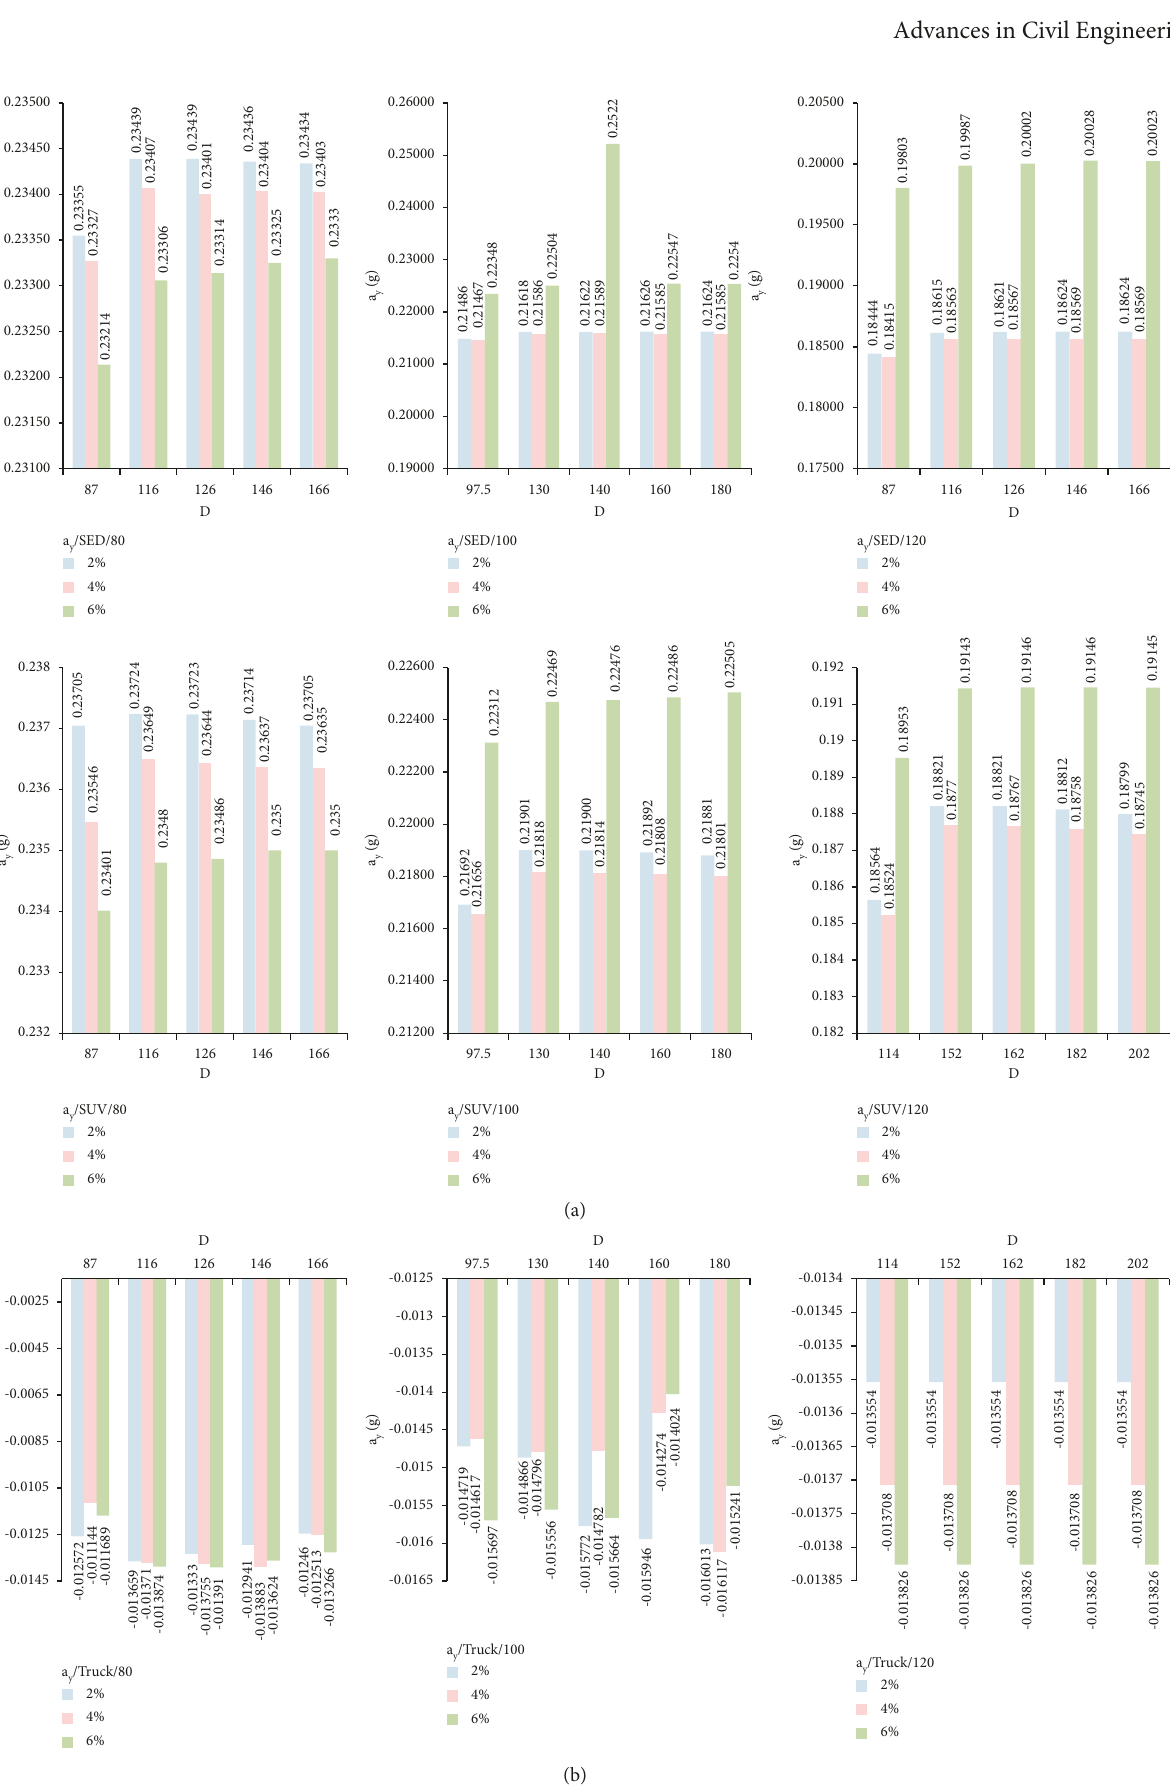
Figure 4: Lateral acceleration changes by changing the direct distance ( D ) at downgrade mode and speeds of 80, 100, and 120